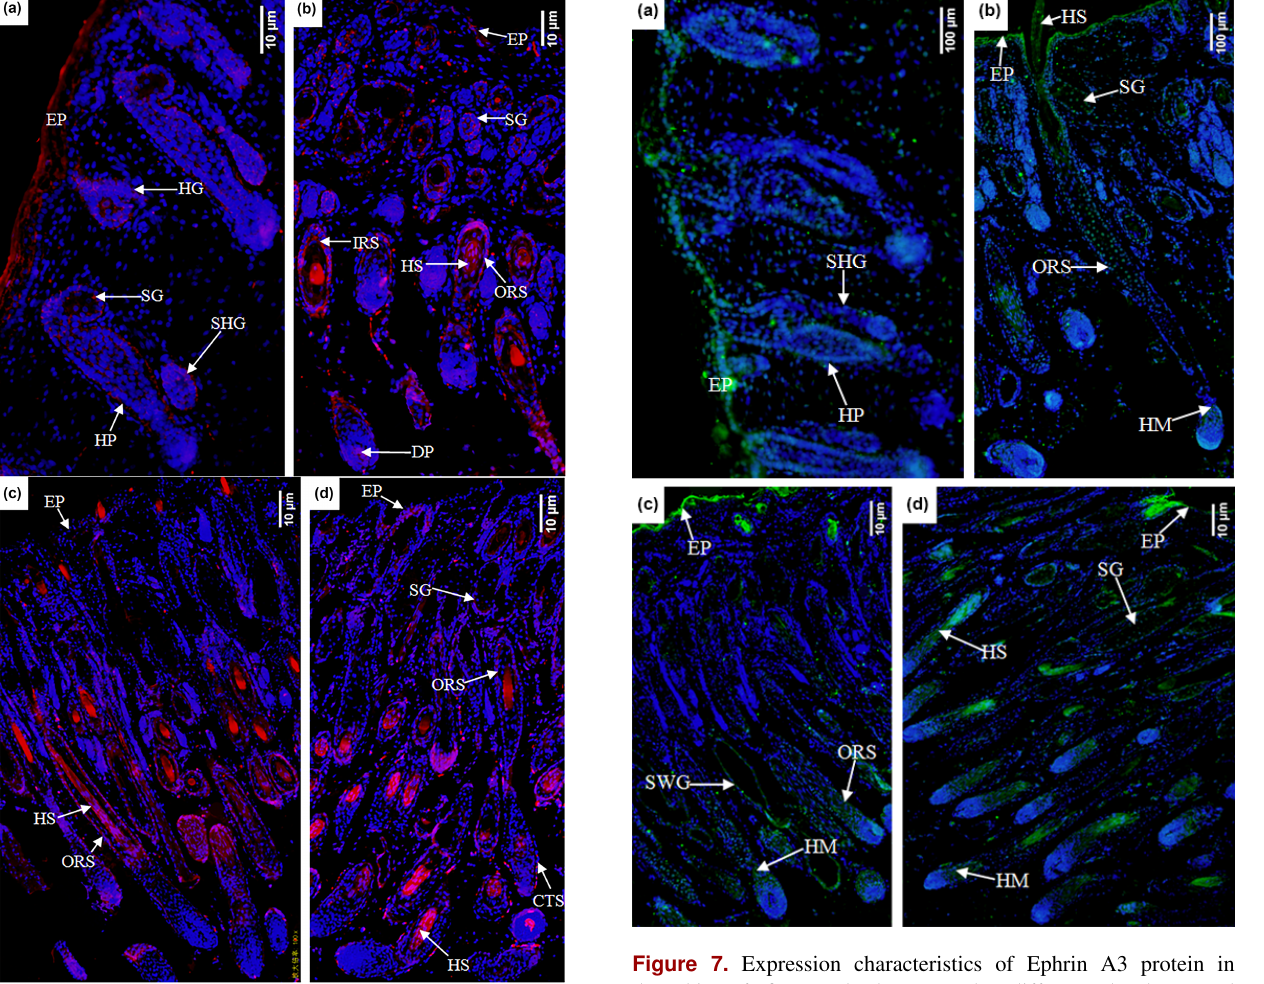
Figure 7. Expression characteristics of Ephrin A3 protein in the skin of fine-wool sheep at the different developmental stages (a) E90d group (200 × ), (b) E120d group (200 × ), (c) B1d group (100 × ), and (d) B30d group (100 × ). All samples were col- lected from the skin on the body side. EP stands for epidermis, HP stands for hair peg, SHG stands for secondary follicle germ, HM stands for hair matrix, SWG stands for sweat gland, HS stands for hair shaft, ORS stands for outer root sheath, and SG stands for se- baceous